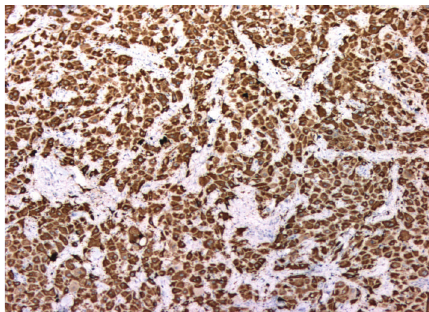
Figure 6: Tumor cells of FLC showing diffuse positivity for CK7, immunohistochemistry